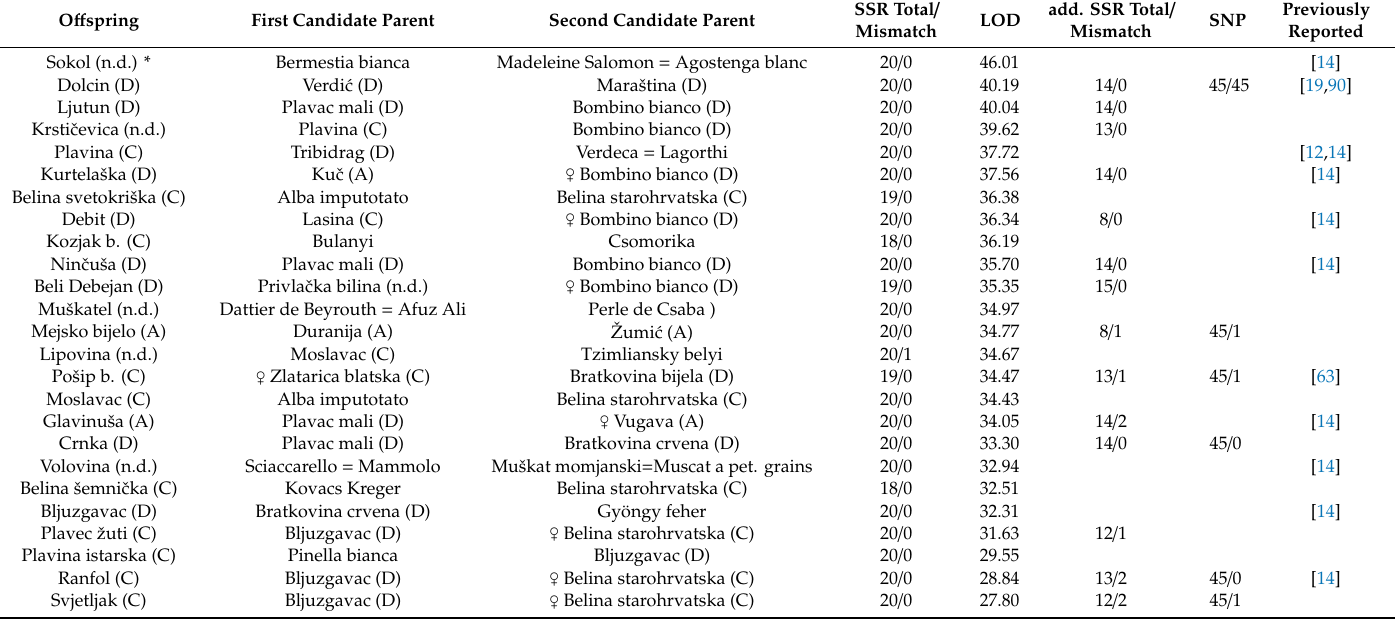
Table 5. Proposed full parentages of Croatian germplasm based on 20 SSR